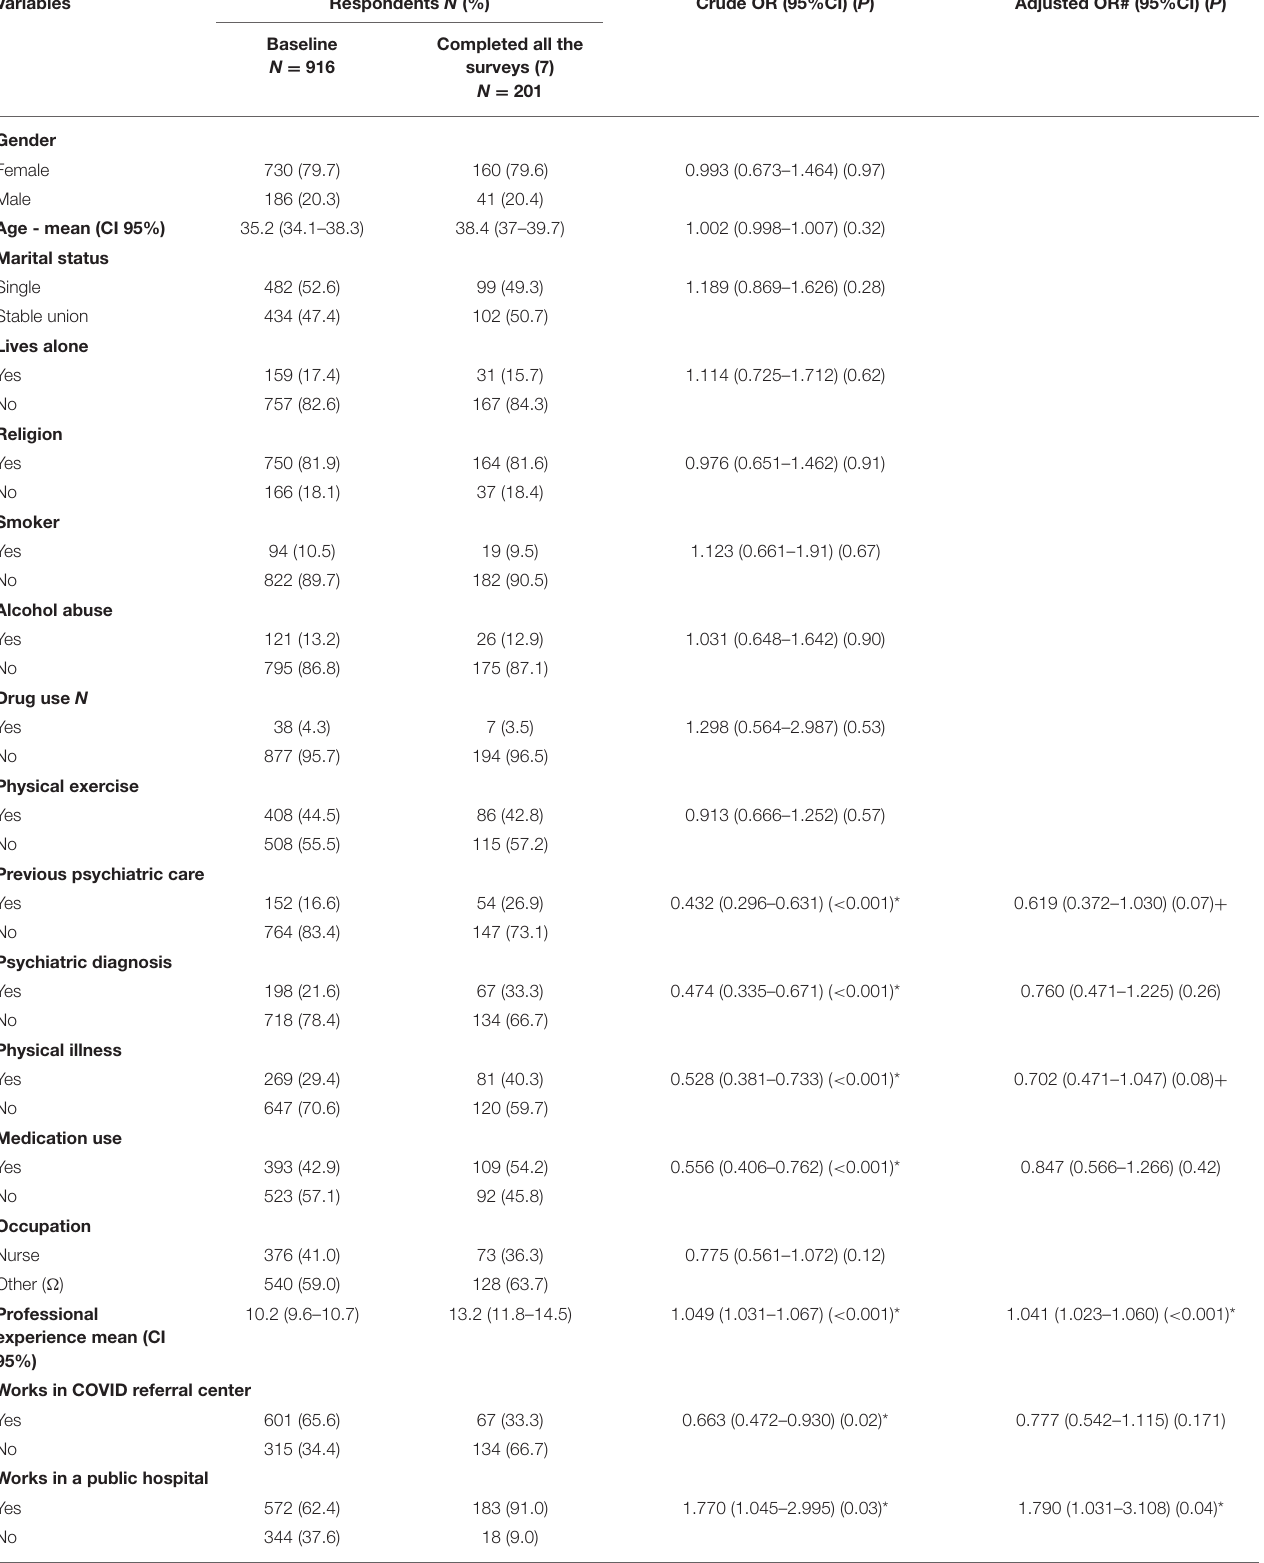
TABLE 1 | Socio-demographic, clinical, and occupational characterization and participants’ risk perception at the baseline and final follow-up.